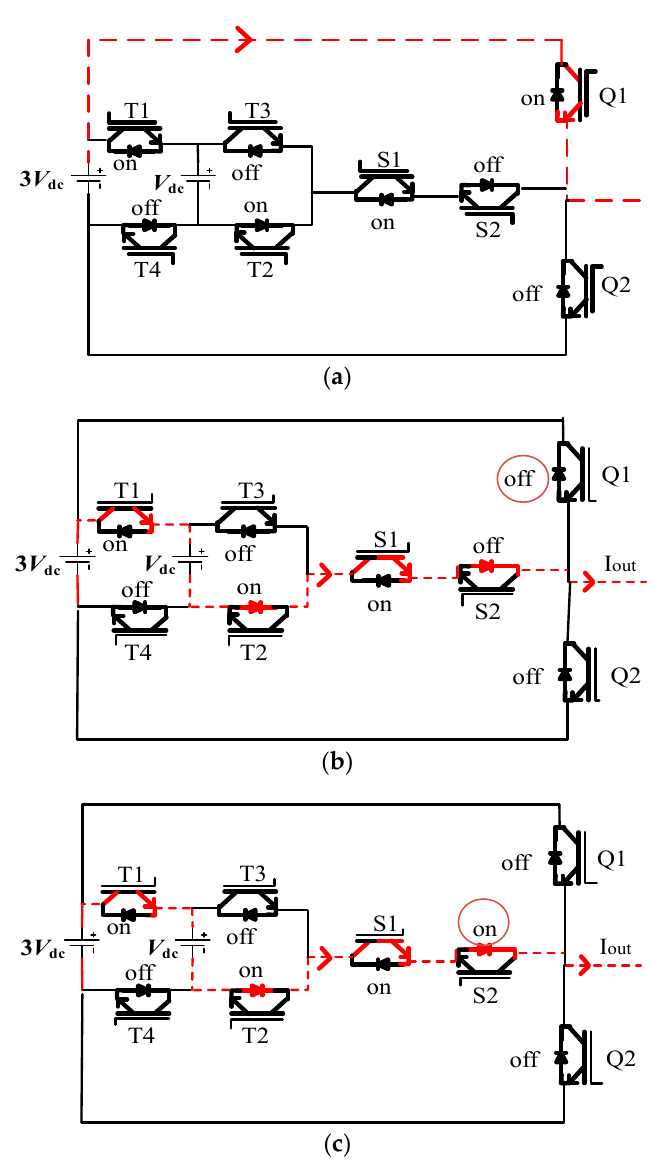
Figure 3. Current commutation during switching transition of positive output current in leg a . ( a ) Output voltage level of 3 V dc (Q1 on and S2 off). ( b ) Output voltage level of 2 V dc (Q1 off and D S2 on). ( a ) Output voltage level of 3 V dc (Q1 on and S2 o ff ). ( b ) Output voltage level of 2 V dc (Q1 o ff and D S2 ( c ) Output voltage level of 2 V dc (Q1 off, D S2 on and S2 on with ZVS). on). ( c ) Output voltage level of 2 V dc (Q1 o ff , D S2 on and S2 on with